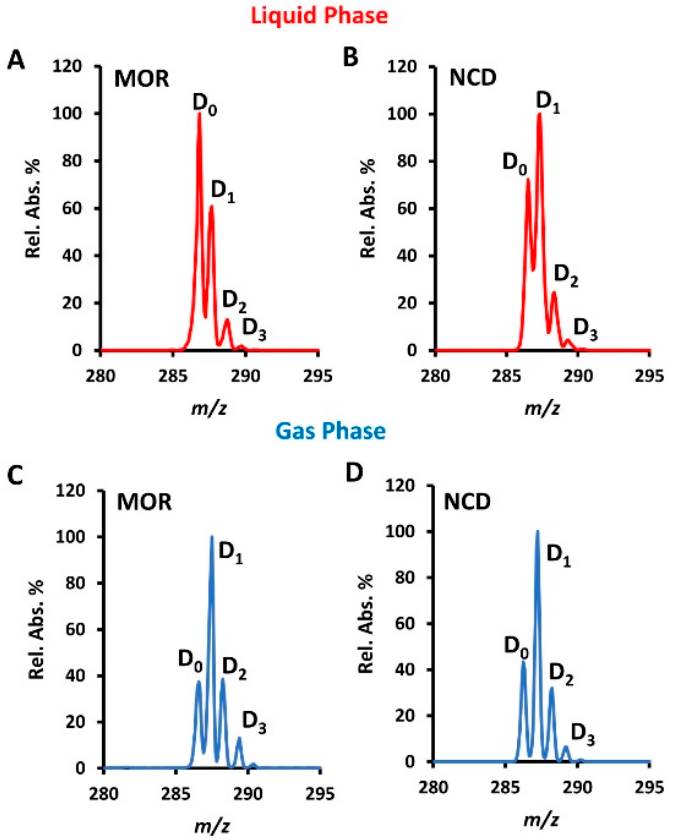
Figure 5. Comparison of HDX that happens in the liquid phase and the gas phase. MOR represents morphine and NCD represents norcodeine. Mass spectra for ( A ) morphine (MOR), ( B ) norcodeine (NCD) after conducting liquid-phase HDX, ( C ) MOR, and ( D ) NCD after conducting gas-phase HDX.